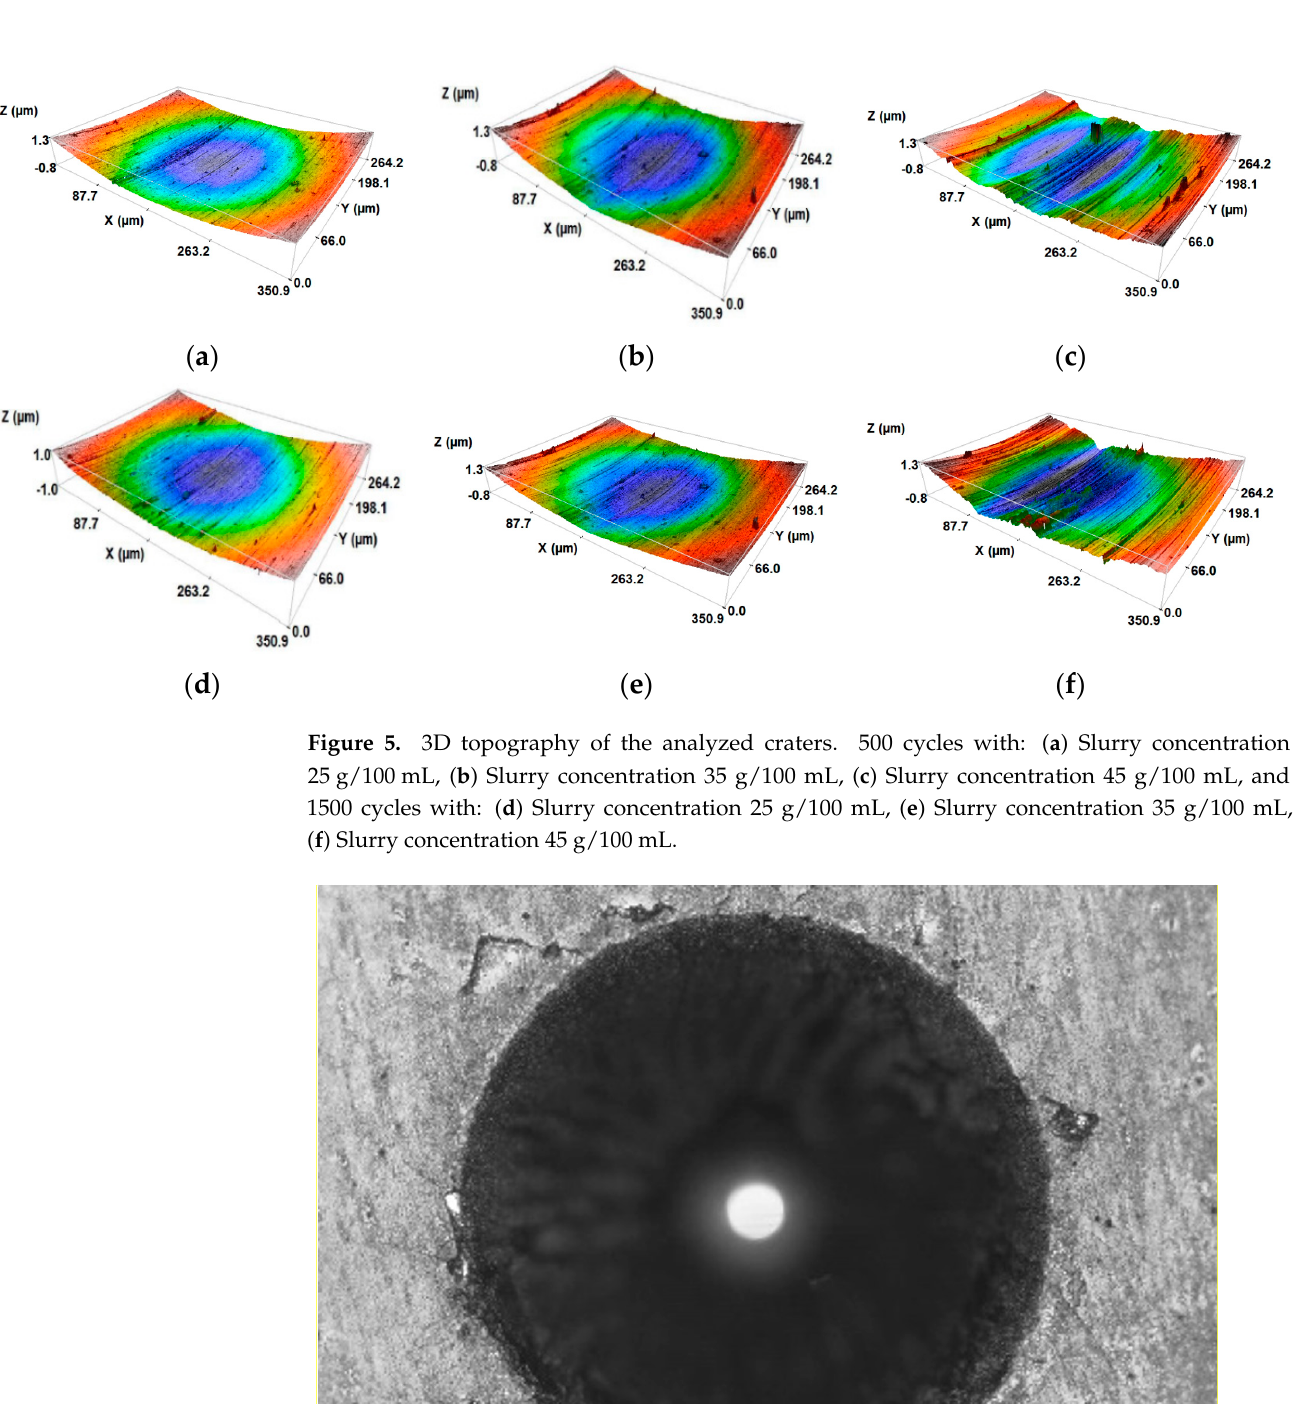
Figure 6. Rockwell-C indentation performed at the TiN film observed in optical microscope. Ab- sence of severe cracks in the border are visible.